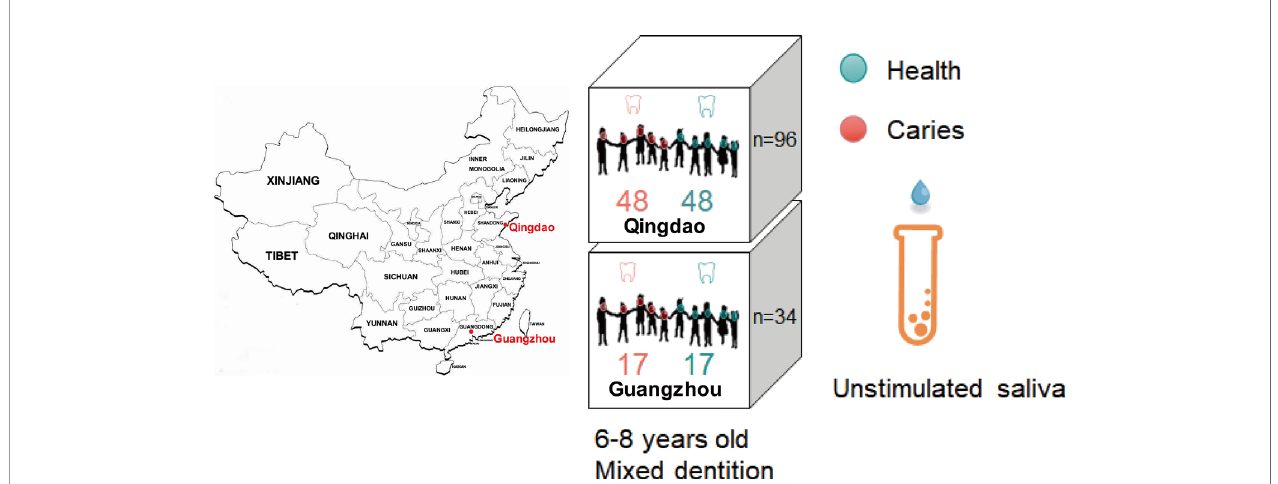
FIGURE 1 | Experimental design that sampled saliva microbiome from caries-affected children and healthy controls in the two Chinese cities of Qingdao and Guangzhou. Unstimulated saliva microbiota from 130 individuals (Qingdao, n=96; Guangzhou, n=34) were